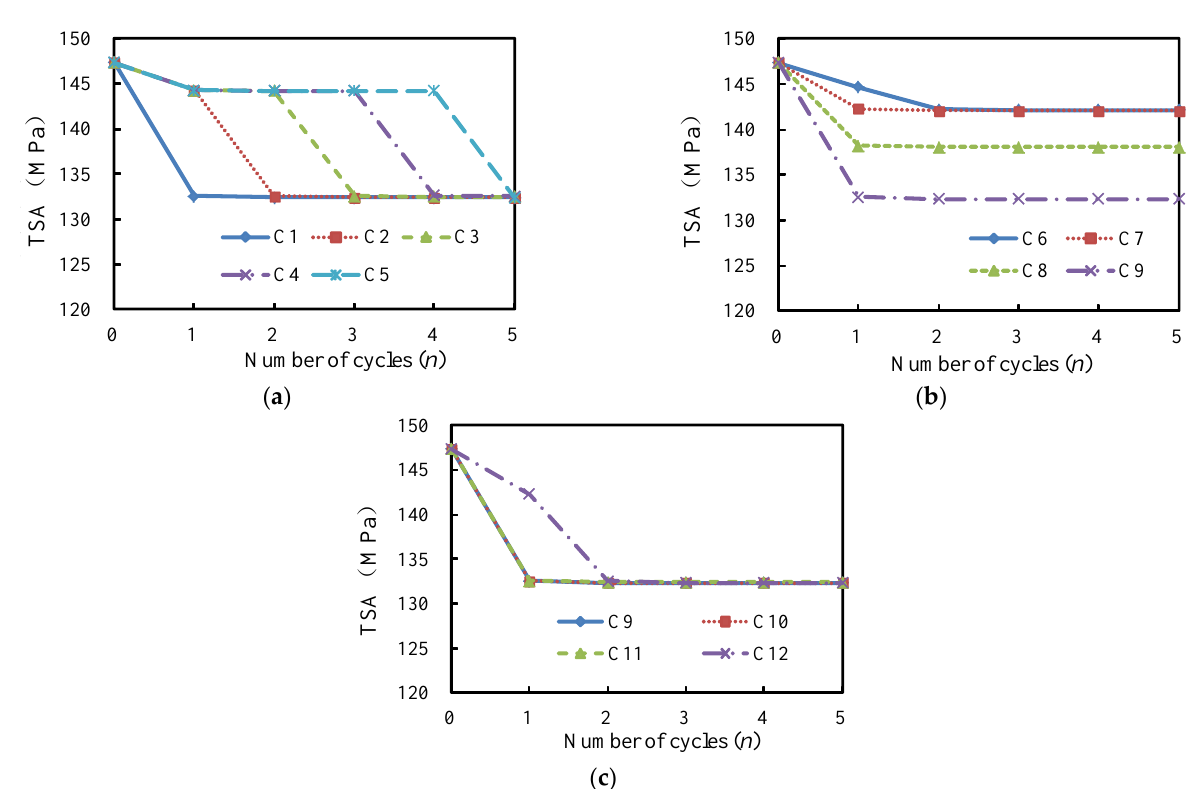
≥ ( σ ) ≥ ( σ ) app app 1 2 3